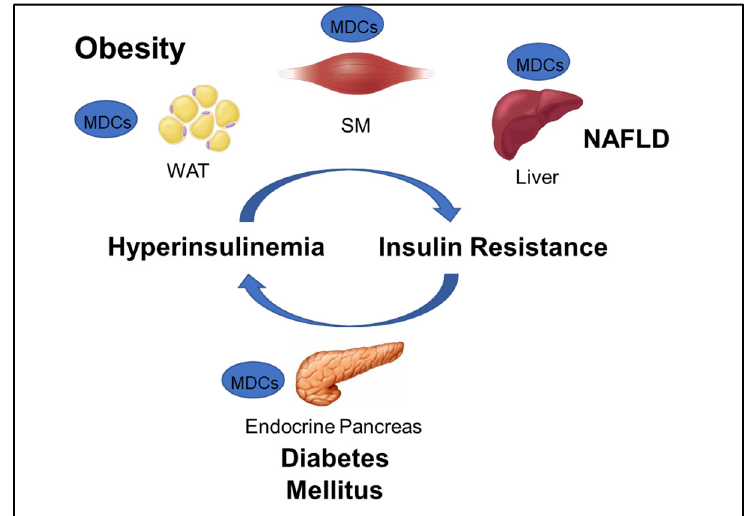
Figure 1. Interconnection between obesity and major metabolic disorders and the corresponding tissues that can be targeted by metabolic disrupting chemicals (MDCs). NAFLD: non-alcoholic fatty liver disease; WAT: white adipose tissue, SM: skeletal muscle.